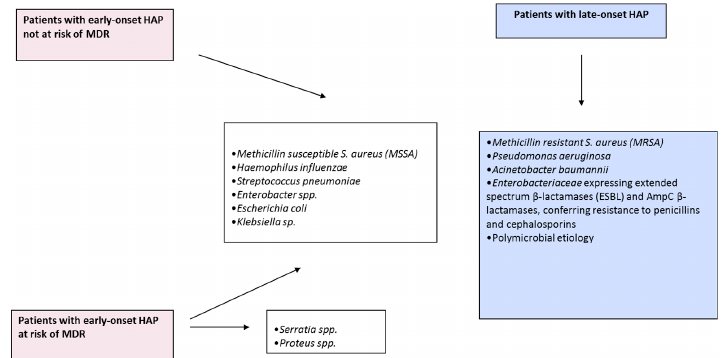
Figure 3. Pathogens associated with Early-Onset and Late-Onset Pneumonia. Abbreviations: MDR = multidrug-resistant pathogen; MRSA = methicillin resistant S. aureus, HAP = hospital acquired pneumonia; MSSA = methicillin sensitive S. aureus; ESBL = extended-spectrum β -lactamase.